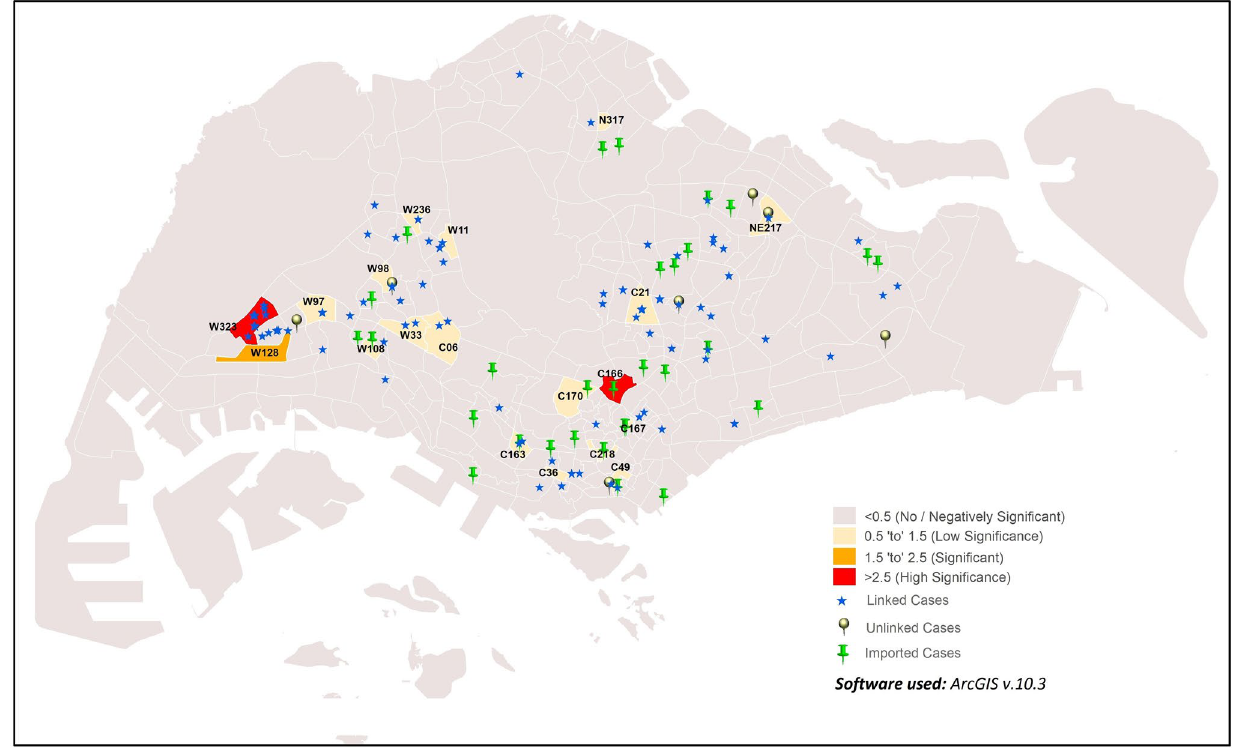
Figure 3. GWR of population density and COVID-19 cases in the early phase of COVID-19 outbreak.